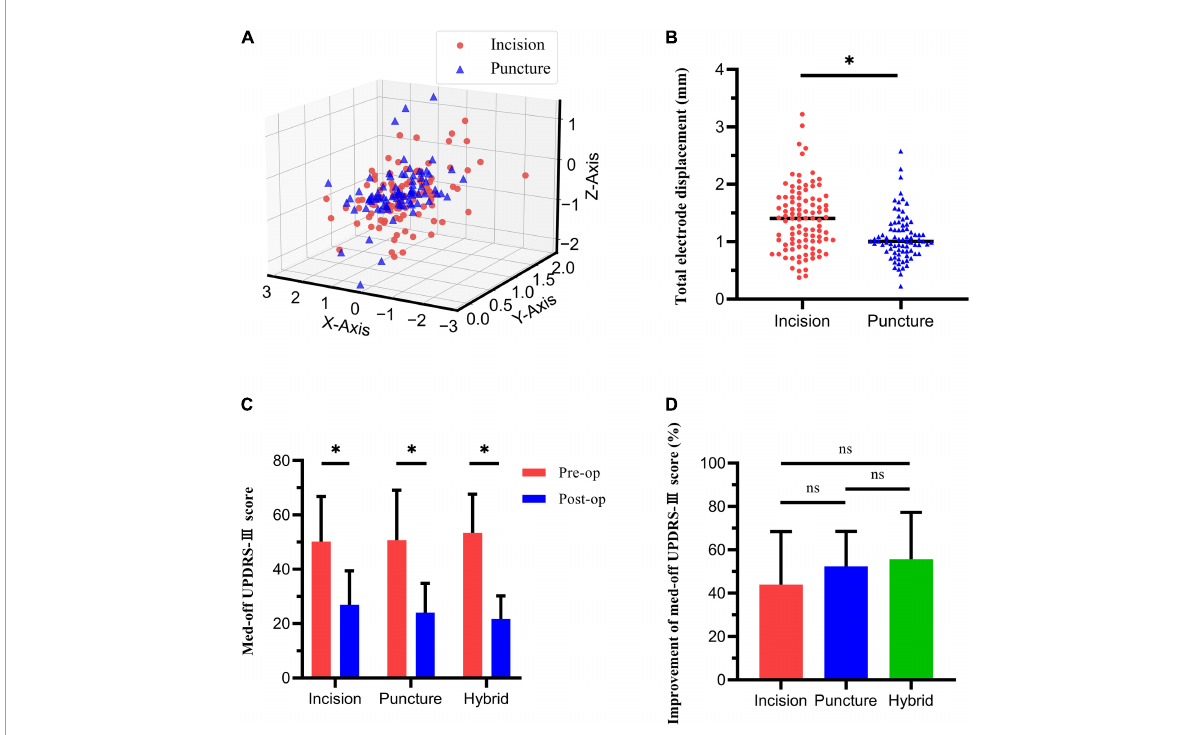
FIGURE4 Electrode displacement and change in med-off Unified Parkinson Disease’s Rating Scale Part-III (UPDRS-III) score. (A) Electrode displacement in X, Y, and Z-axes in dural incision and dural puncture groups. (B) Total electrode displacement significantly differed between the dural incision and dural puncture groups. (C) Med-off UPDRS-III score before and after deep brain stimulation surgery in three groups. (D) Improvement of med-off UPDRS-III score did not significantly differ among three groups. ∗ P < 0.05; ns, no significance.